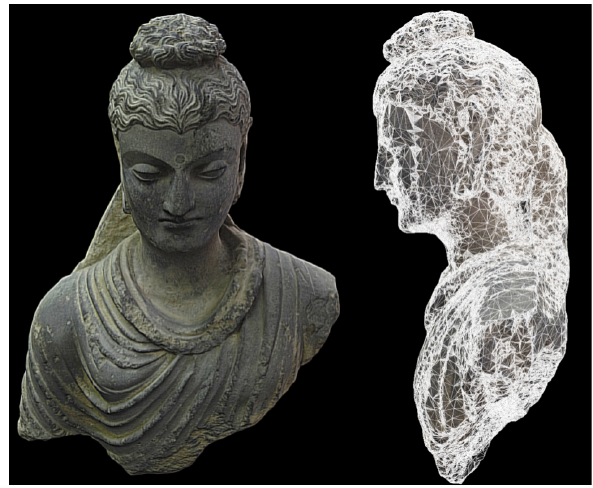
Figure 4: Shakyamuni deity carved grey schist of the ancient region of Gandhara circa 2nd century. Cyber-archive by Photogrammetry.